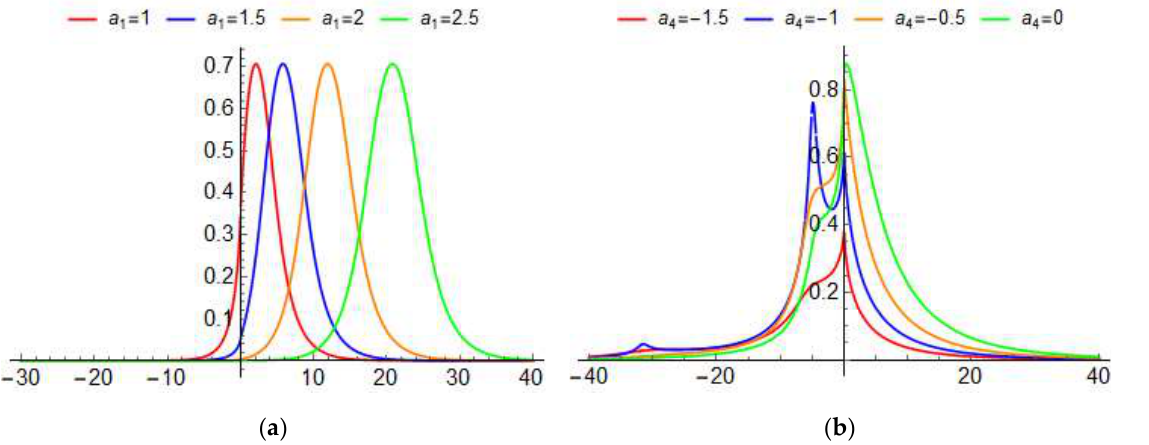
(cid:113) q (cid:3002) (cid:3044) (cid:3118) 2 for (cid:3495) 2 q 3 β (cid:3081) (cid:2870)(cid:3044) (cid:3119) 𝐴 = 1,ℬ = 0.3, 𝑎 (cid:2869) = 1,𝑞 (cid:2870) = 4 where: